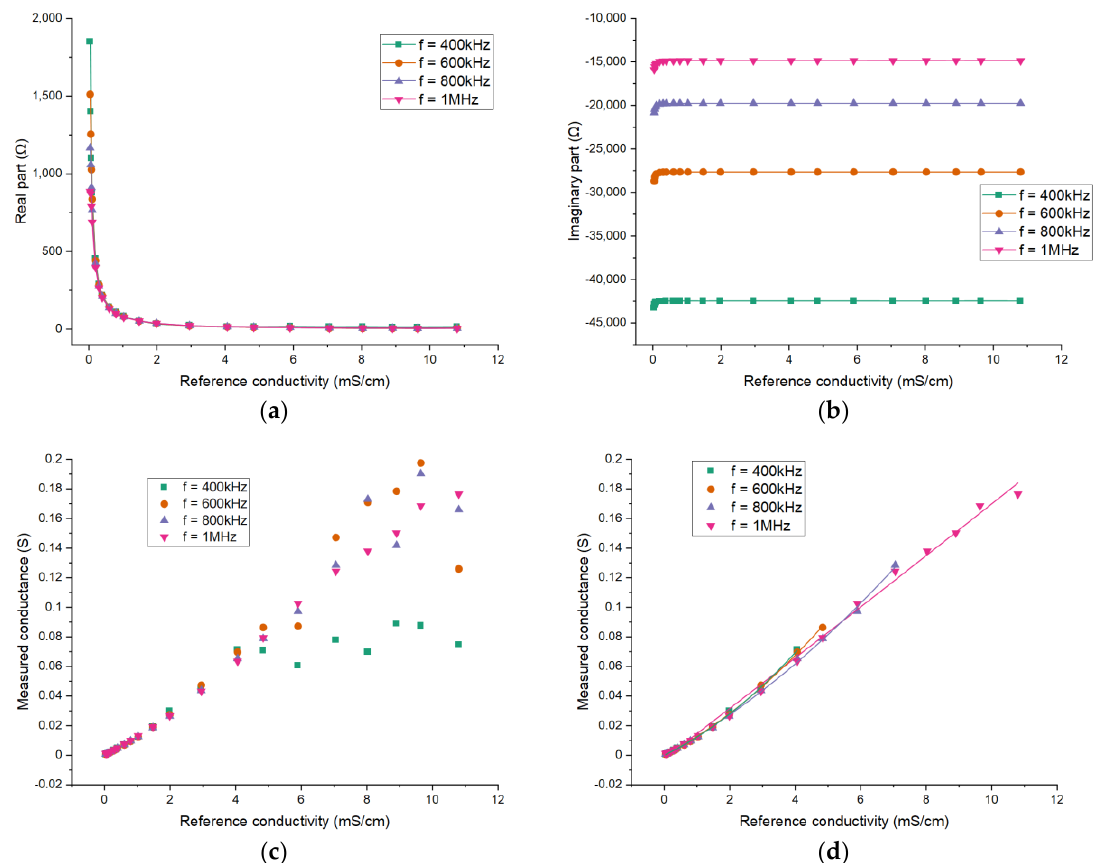
Figure 12. Experimental results for different excitation frequencies: The dependence of ( a ) the real part of the impedance; ( b ) the imaginary part of the impedance; ( c ) the measured conductance on the conductivity of the solution; ( d ) the conductance results with conductivity within the corresponding upper limit.